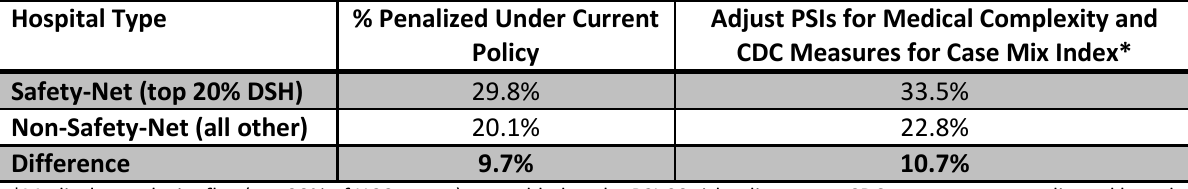
Table 6.16: Percent Penalized After Adjusting PSIs for Medical Complexity and CDC measures for Case